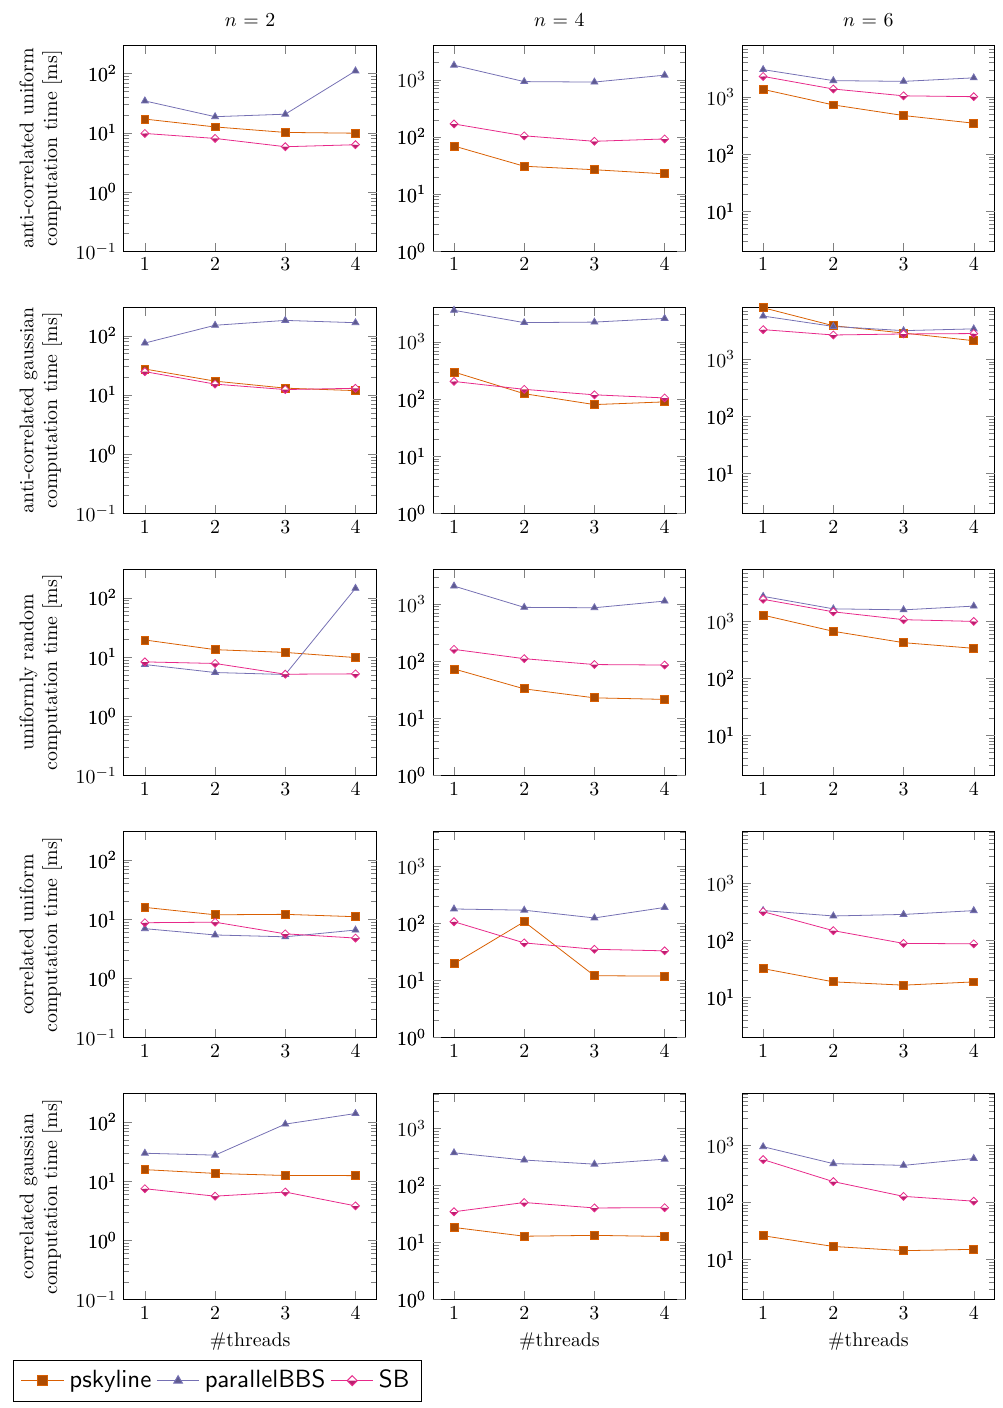
Figure 7. Experiment varying the number of threads with fixed input size of 700,000 tuples. The time ( y -axis) is in milliseconds and logarithmic scale. Each row uses a different random distribution of the input values, and each column corresponds to a specific dimension n of the feature vectors. The number of threads varies from one to